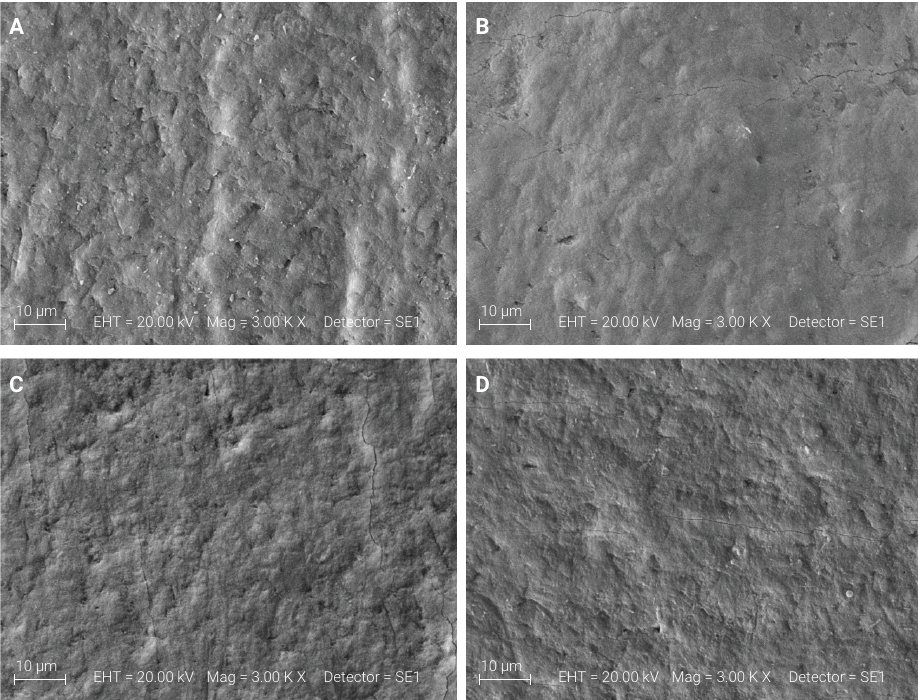
Figure 1: A. Violet LED; B. 7.5% Hydrogen peroxide; C. 7.5% Hydrogen peroxide + Violet LED; D. No